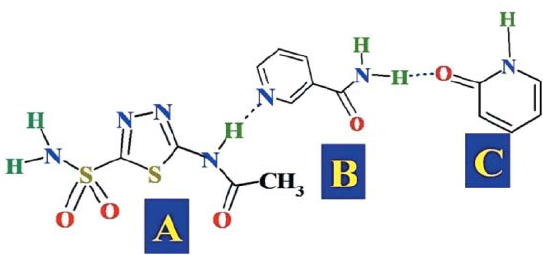
Figure 22. Long-range Synthon Assembly Module (LSAM) observed in acetazolomide-nicotinamide-hydroxypyridine (1:1:1) ternary cocrystal [Reprinted from [267] with permission of International Union of Crystallography].